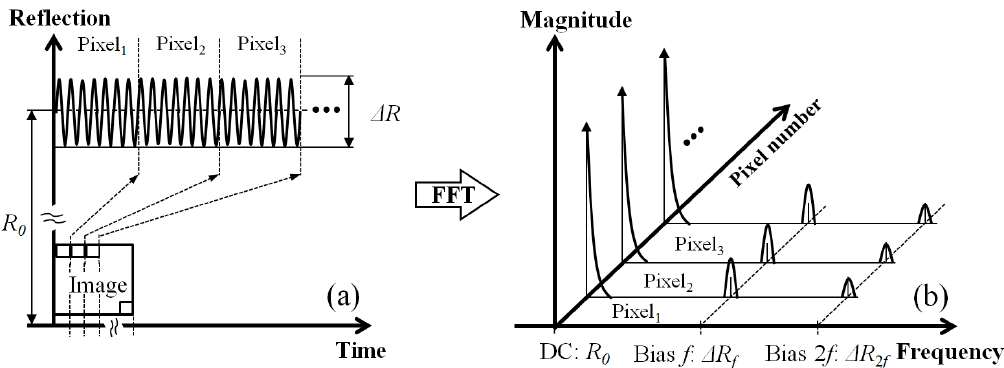
Figure 3. ( a ) Individual data set for the time-varying reflected laser beam as a single pixel and ( b ) reflectivity variations in the frequency domain after the FFT.